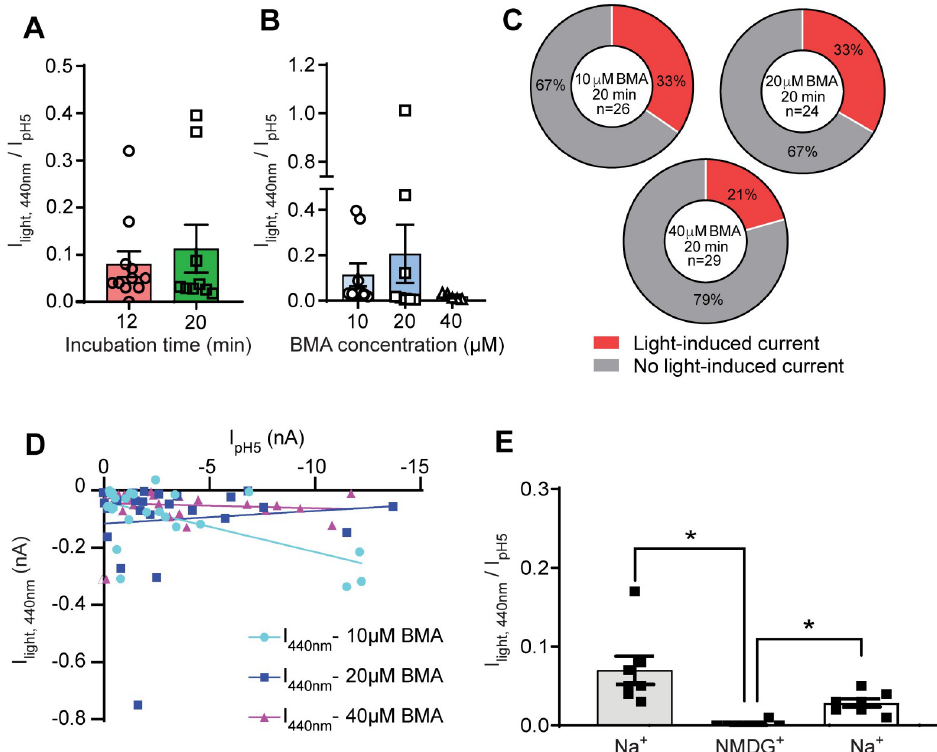
Fig 2. Characterization of light-activated currents in I428C. Data were obtained from whole-cell patch-clamp recording of hASIC1a-I428C-expressing CHO cells, voltage-clamped to -60mV. A , Light-induced current amplitudes normalized to the IpH5 measured in the same cells, obtained after incubation with 10 μ M BMA for 12 or 20 min. B, Light-induced current amplitude normalized to IpH5 measured in the same cell, obtained after incubation of I428C with different concentrations of BMA for 20min. C , Occurrence of cells in which a light-induced current ( � 20pA) was measured (red) or not (grey), after a 20-min incubation at different concentration of BMA. D . Current amplitudes obtained under 440nm light were compared with the IpH5 measured in the same cell, for incubation conditions containing 10 μ M, 20 μ M or 40 μ M BMA. Linear regression analysis did not show any significant correlation between the current amplitude induced by pH5 and by 440nm light. E , Light-induced current amplitude, normalized to IpH5 in the same cell, obtained with extracellular solutions containing Na + or NMDG + . The light stimulation in the NMDG + solution was carried out between the two indicated stimulations in the Na + solution; the stimulation interval was 1min. � , p < 0.05 between indicated conditions (one-way ANOVA with Sidak’s post-hoc test).